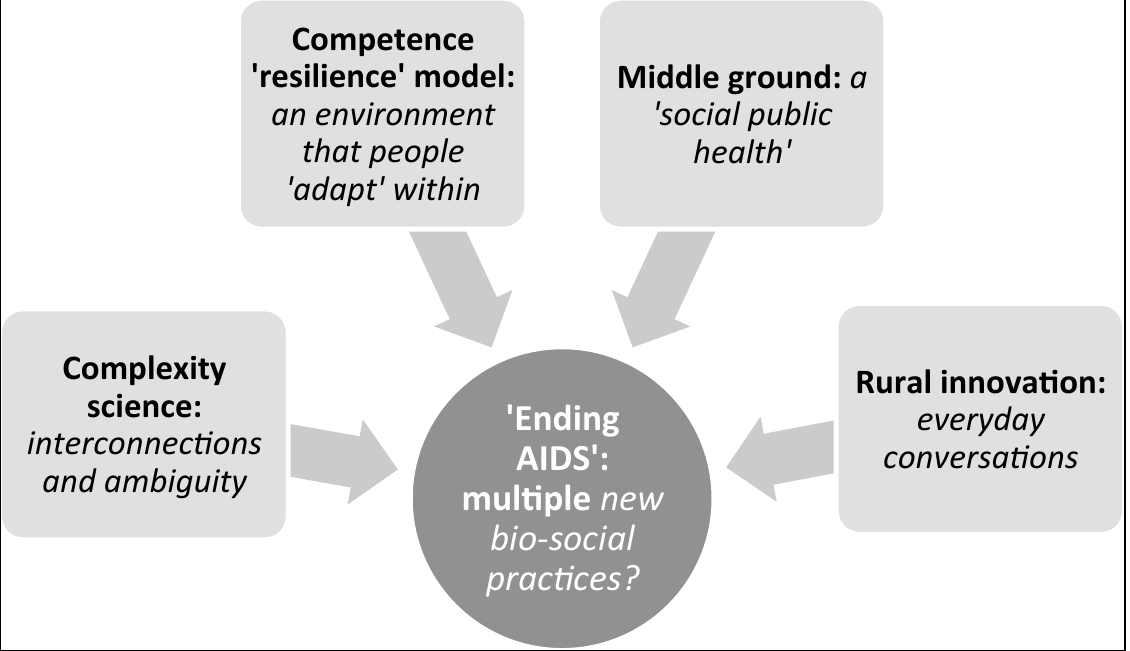
Figure 2: An overview of the transdisciplinary perspectives. Source: authors' contribution Complexity, the ‘middle ground’ and ‘everyday conversations’ all converge on points of similarity: an adoption of a new practice is social, ambiguous, constrained and influenced by historical particularities. The ‘competency model’ appears to be based upon a belief about what ‘should’ happen if communities construct — and then adapt to — the structures that the model identifies. Based on the above we now turn to the case